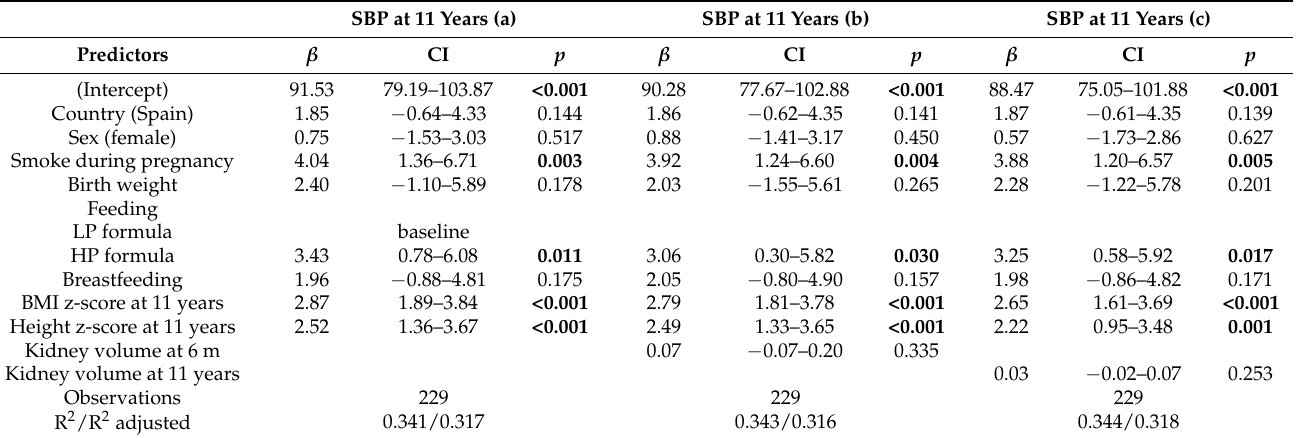
Table 4. Linear regression models to predict systolic blood pressure at 11 years of